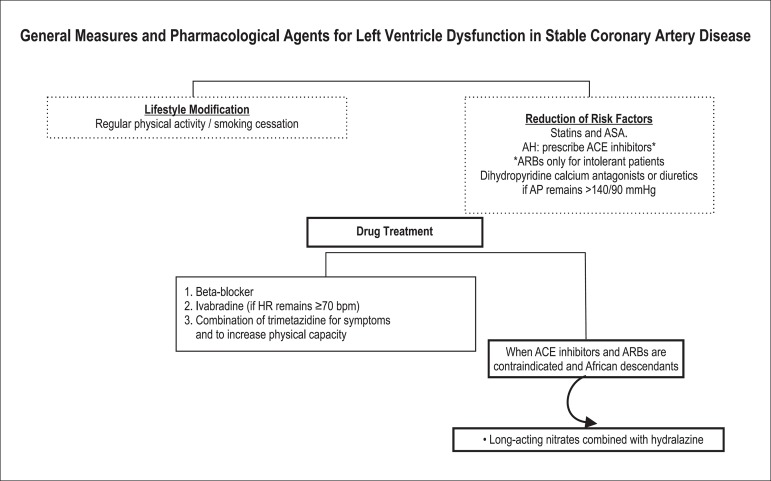
Algorithm for reduction of cardiovascular events in the presence of left
ventricular dysfunction. Details, levels of recommendation and evidence level:
see the corresponding text. ASA: Acetylsalicylic acid; AH: Arterial
hypertension; ACE inhibitors: Angiotensin-converting enzyme inhibitors; ARB:
Angiotensin receptor blocker I; AP: Arterial pressure; HR: Heart rate.